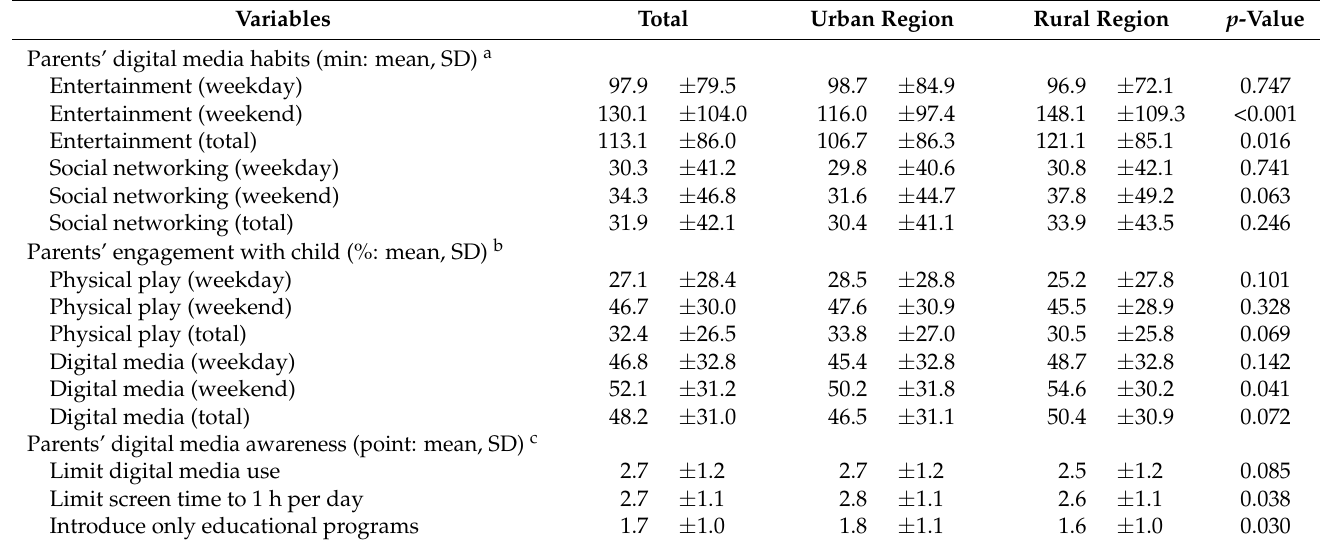
Table 2. Digital media habits, engagement, awareness, and urban/rural differences among